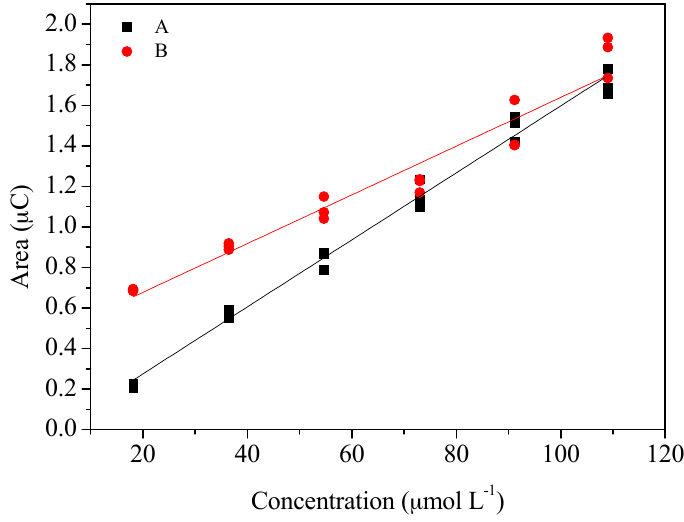
Figure 6. Comparison of 2 linear curves for glycerol analyses performed on different days with different electrodes. Table 2. Study of method repeatability and